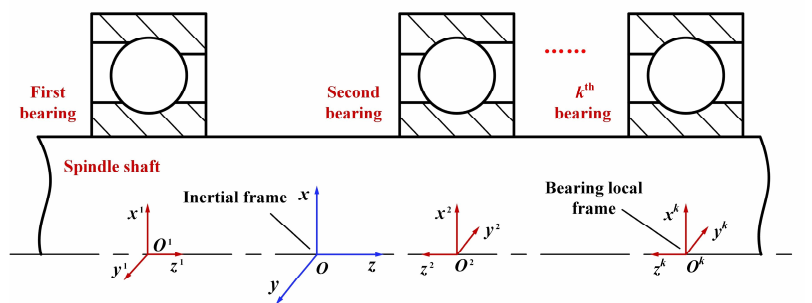
Figure 1. Geometrical configuration of a shaft-bearing system.